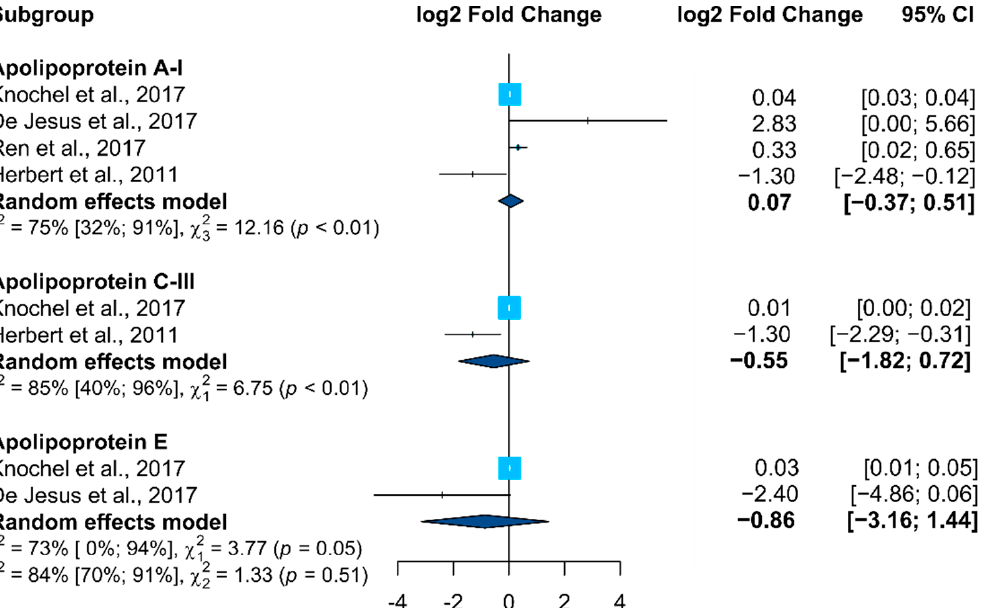
Figure 4. Forest plot from the meta-analysis of proteins identified as altered in BD vs. control studies in at least two studies (95% CI, confidence intervals). Squares (whiskers represent 95% CI) indicate the effect sizes of the individual studies. The size of the squares reflects the sample size of each individual study. Diamonds represent summary statistics.